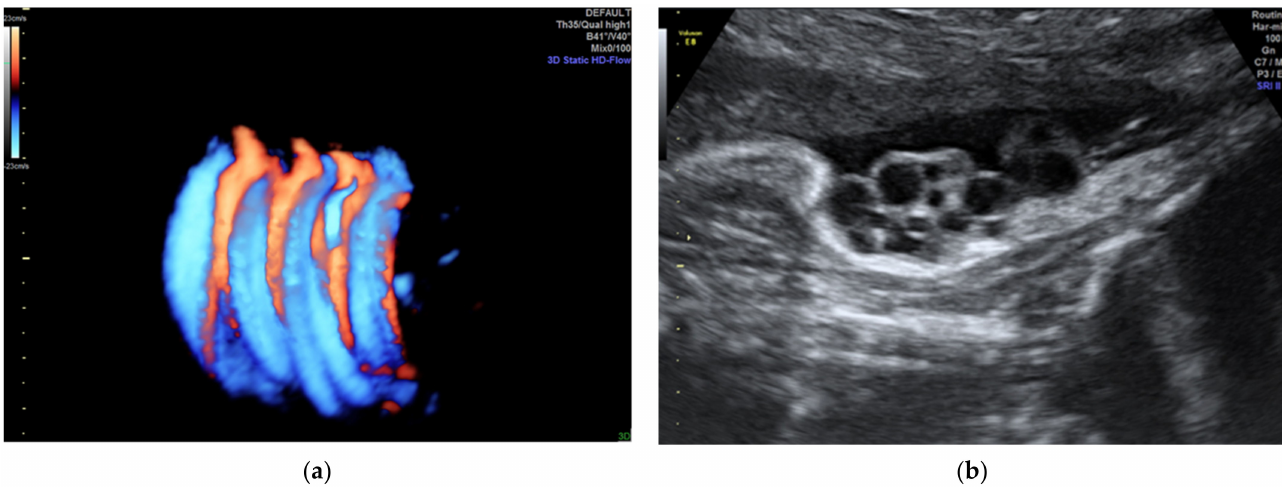
Figure 9. Example of a complex nuchal cord counting 5 loops ( a ) 3D Static HD Flow imaging and ( b ) 2D ultrasound